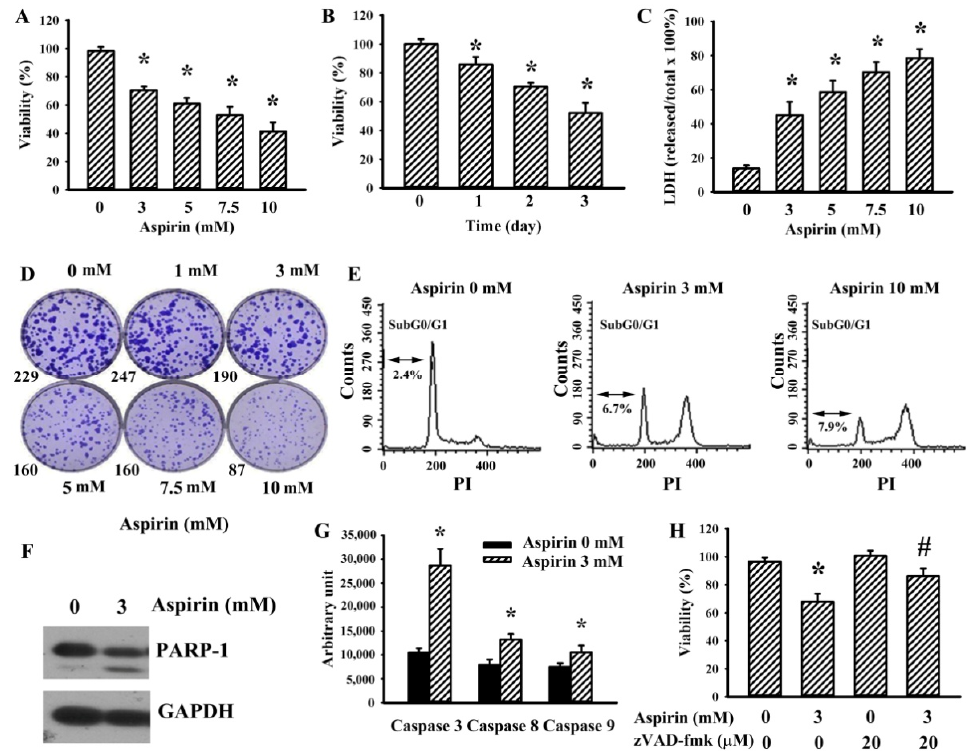
Figure 1. Aspirin caused cell viability loss in H4 cells. ( A ) H4 cells were treated with